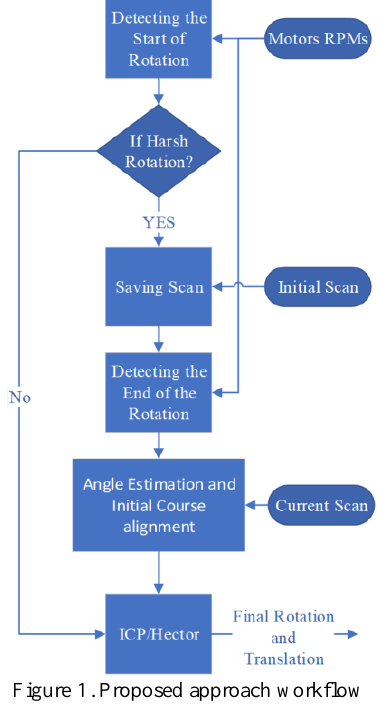
Figure 1. Proposed approach workflow